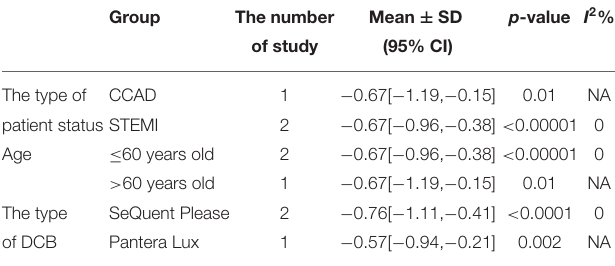
TABLE 5 | The subgroup analysis of MLD1.